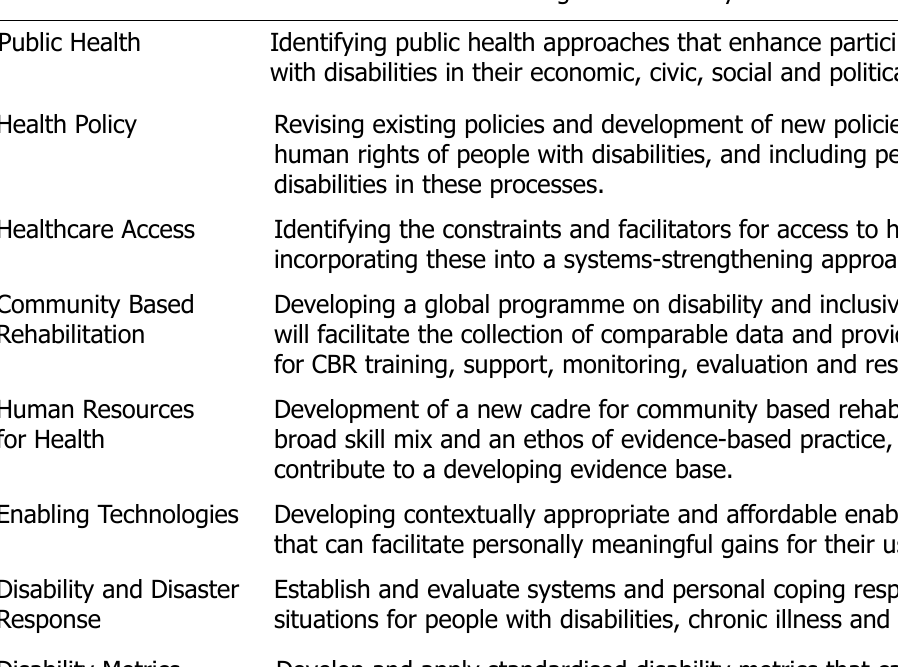
Table 3. Research challenges for disability and